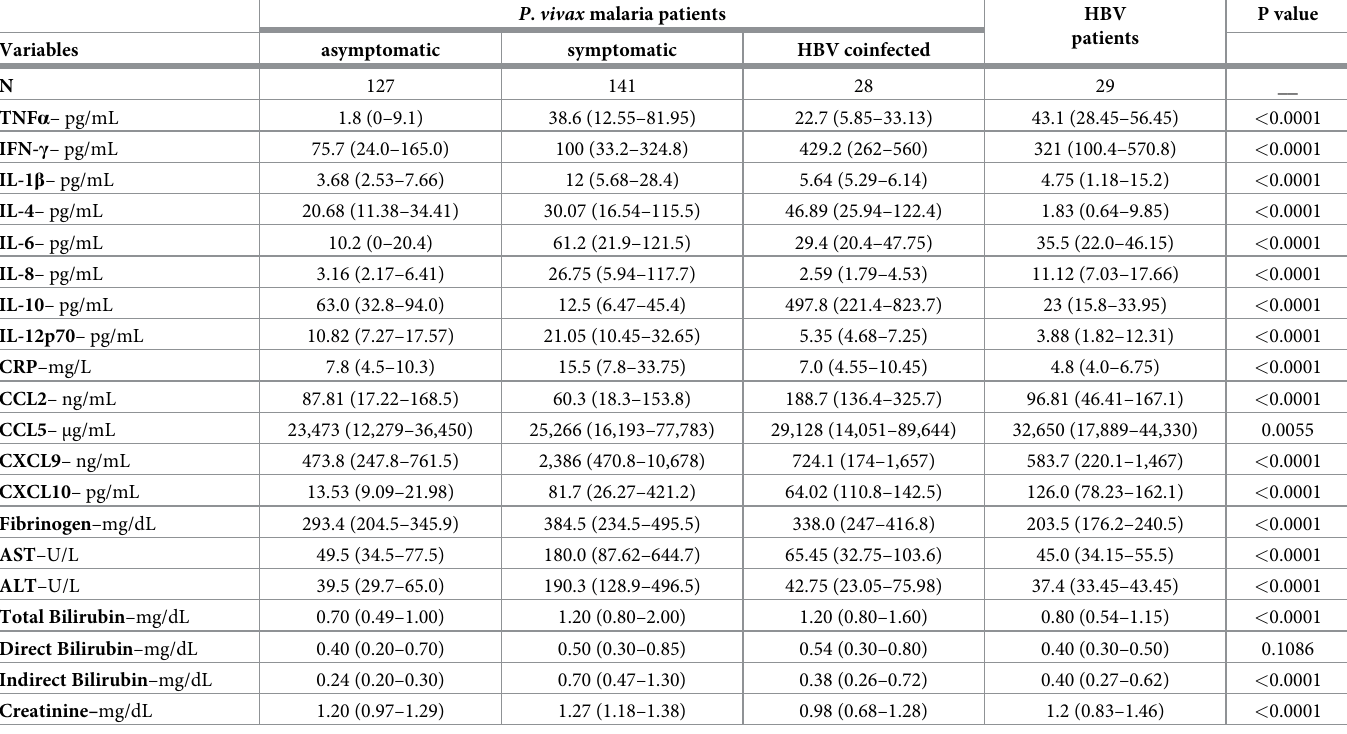
Table 2. Biochemical evaluation of the study